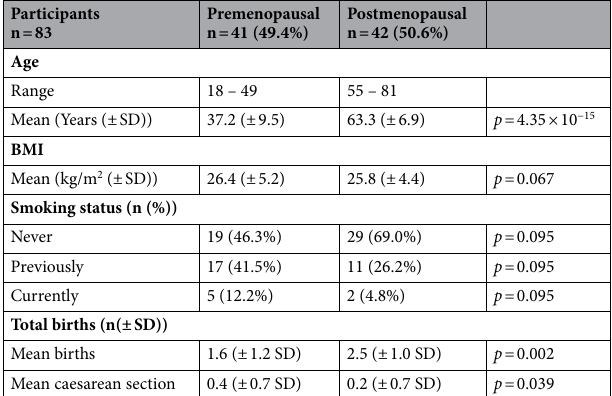
(Table 1). The postmenopausal women had a higher mean number of total births but less caesarean sections compared to premenopausal women. DNA purification from the urine samples showed presence of DNA, albeit for some samples at low concentra- tions, ranging from below 1 ng/mL urine to 15,000 ng/mL urine. To avoid miss- or over-interpretation of bacte- rial status, the DNA concentration was subsequently evaluated after the initial PCR during library preparation for 16S ribosomal RNA (rRNA) gene sequencing. Samples that produced lower DNA concentrations following library generation, compared to the negative controls, were excluded in all subsequent analyses (supplementary Fig. S1a). This resulted in urine samples from 29 women being excluded, leaving 34 women in the premenopausal group and 20 women in the postmenopausal group in the data analysis. Subgroup analyses revealed that the excluded women were older ( p = 0.021), contained fewer active smokers ( p = 0.036 and 0.030 for all women and